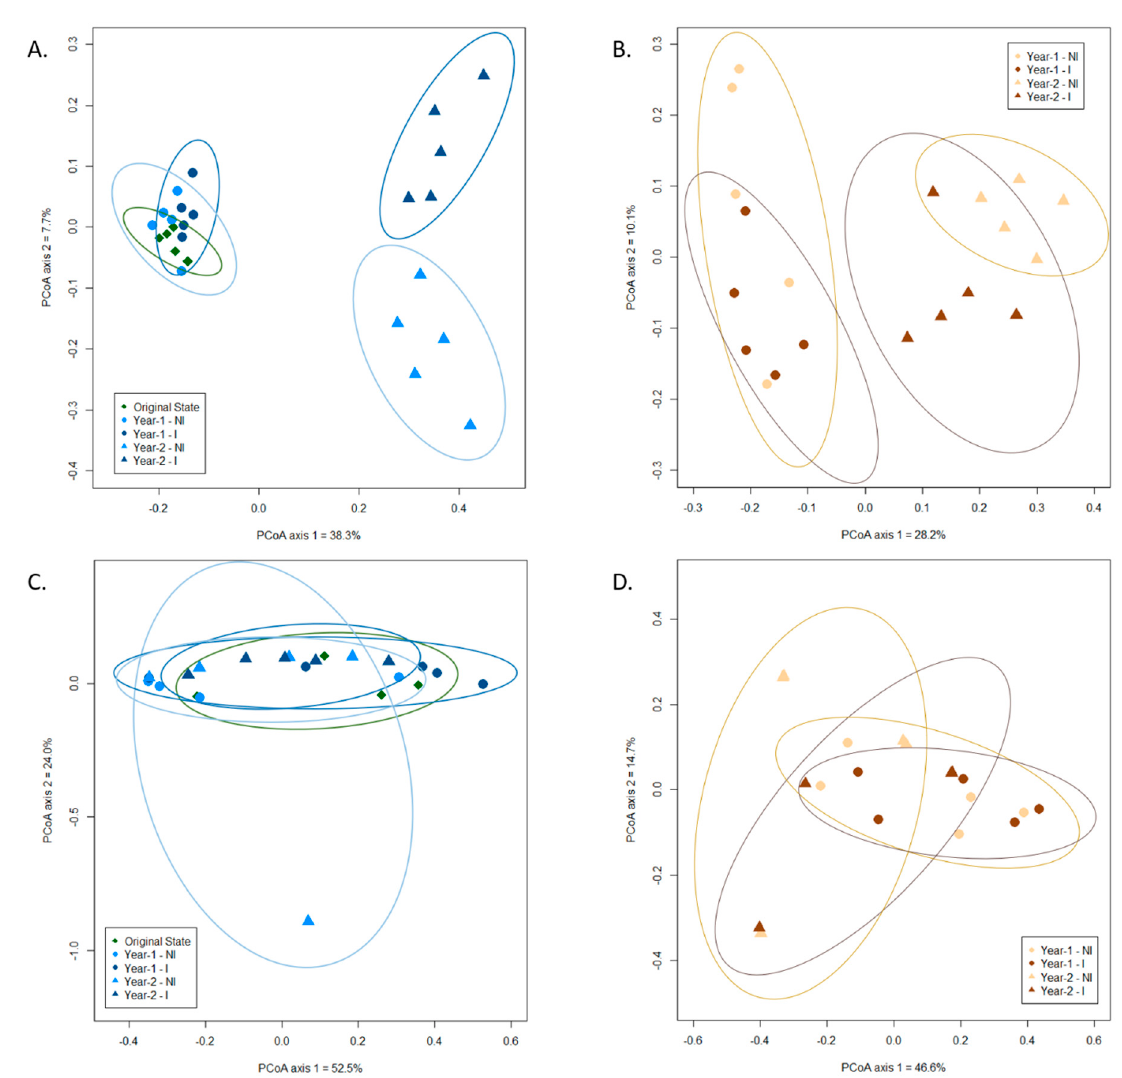
Figure 2. Principal coordinate analysis (scaling 1) based on Bray–Curtis dissimilarity for soil ( A ) and ( C ) and root ( B ) and ( D ) fungal ASVs from the ITS ( A) and ( B ) and 18S ( C ) and ( D ) data sets in the different experimental conditions. Confidence area of ellipses = 0.95. NI: non-inoculated; I: inoculated.